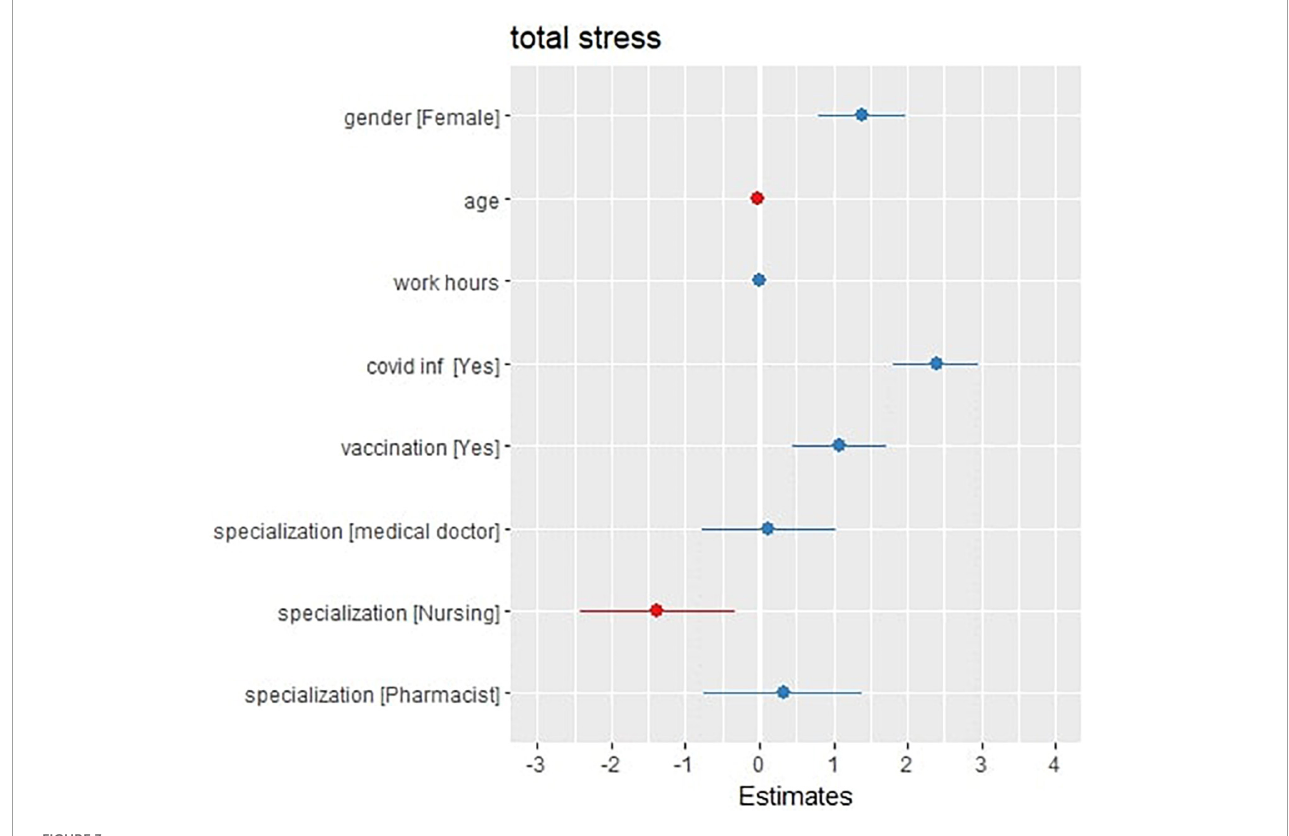
FIGURE3 Forest (dot whisker) plot of the stress generalized non-linear regression model (shows the positions and direction of significance).